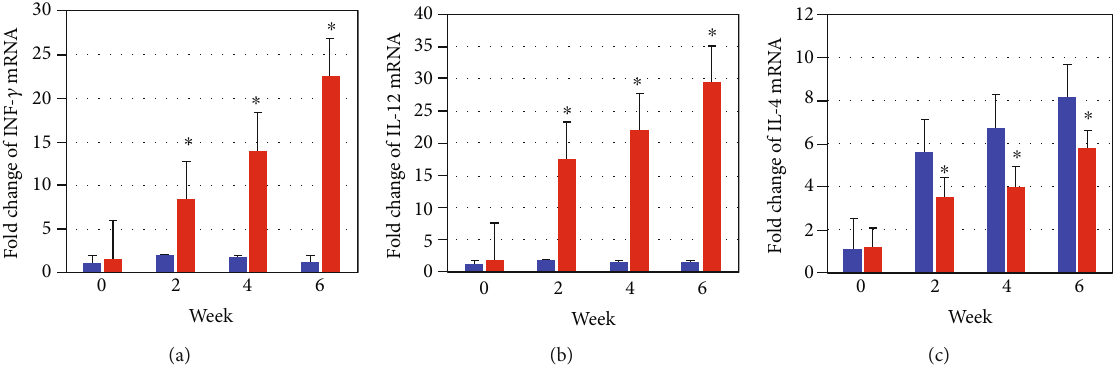
Figure 7: (a) IFN- γ , (b) IL-12, and (c) IL-4 gene expression in the draining lymph nodes obtained from BALB/c mice inoculated with 100 μ g pCI-L5 vaccine. The messenger RNA (mRNA) for IFN- γ , IL-12, and IL-4 gene were determined by RT-qPCR. As geometric mean ± SD (three DLNs). The relative quanti fi cation was performed by the comparative Ct method ( ΔΔ Ct), using the lymph node from the control group as a calibrator ( foldchange = 1 ). ∗ P < 0 : 05 , signi fi cant decrease or increase in cytokine gene expression in the vaccinated group draining lymph nodes compared to the control group.